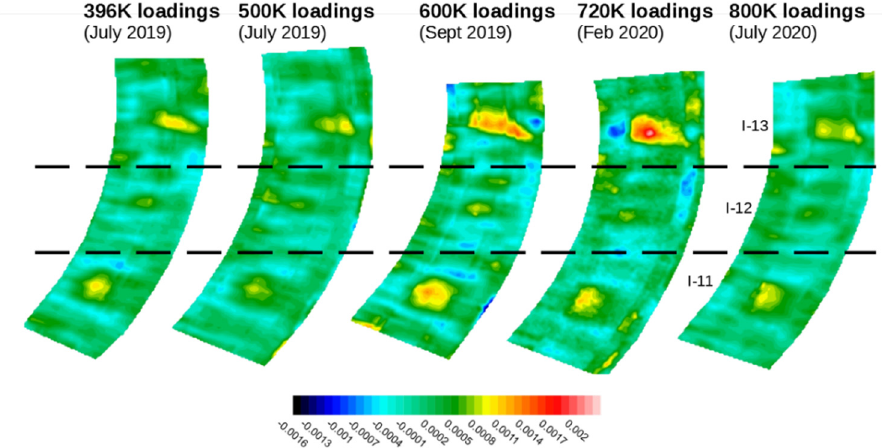
Figure 11. Maps of the surface direct wave extracted from C-scans in the area of I-11 to I-13 (values in Legend refer to the amplitude of the received signal).